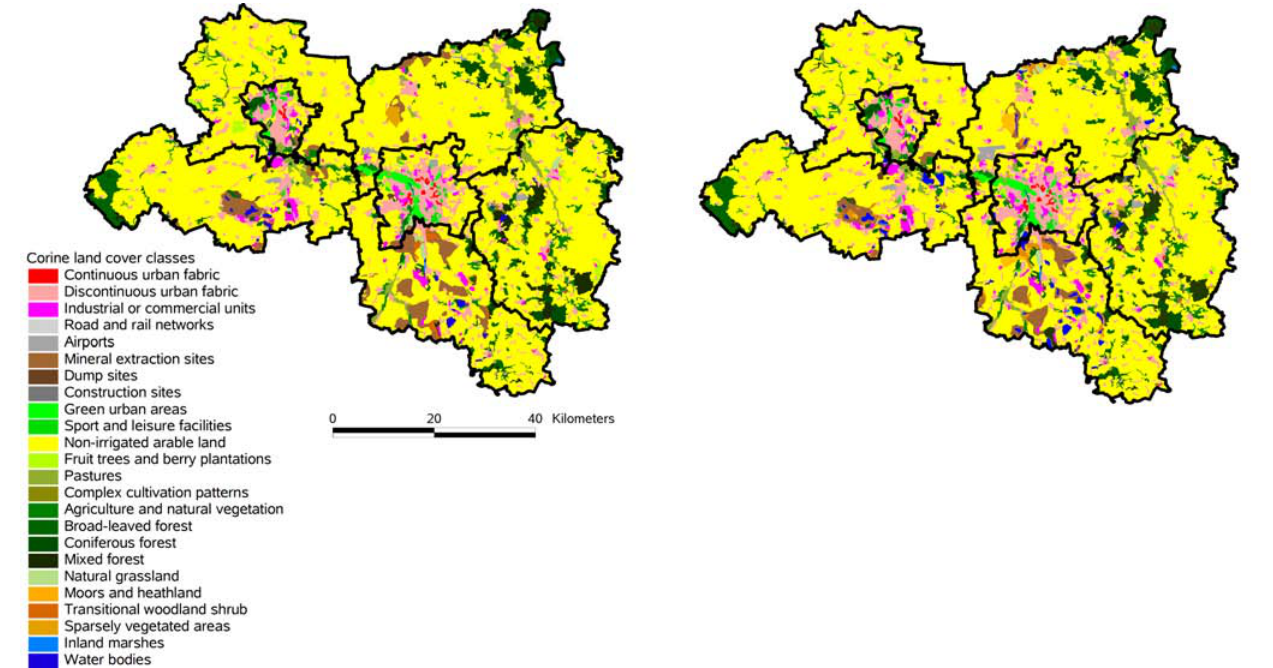
Figure 2: CORINE land cover maps of the research area, showing the land cover distribution of 1990 (left) and 2000 (right) and the administrative borders of Leipzig, Halle, and surrounding